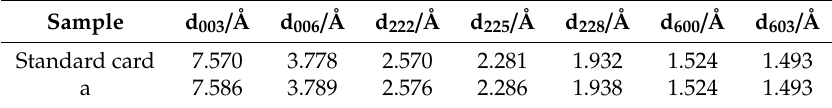
Figure 1. XRD patterns of Mg 2 Al-CO 3 LDHs prepared with ( a ) CO 2 and ( b ) noneas carbon sources. Table 1. Crystal parameters of LDHs.